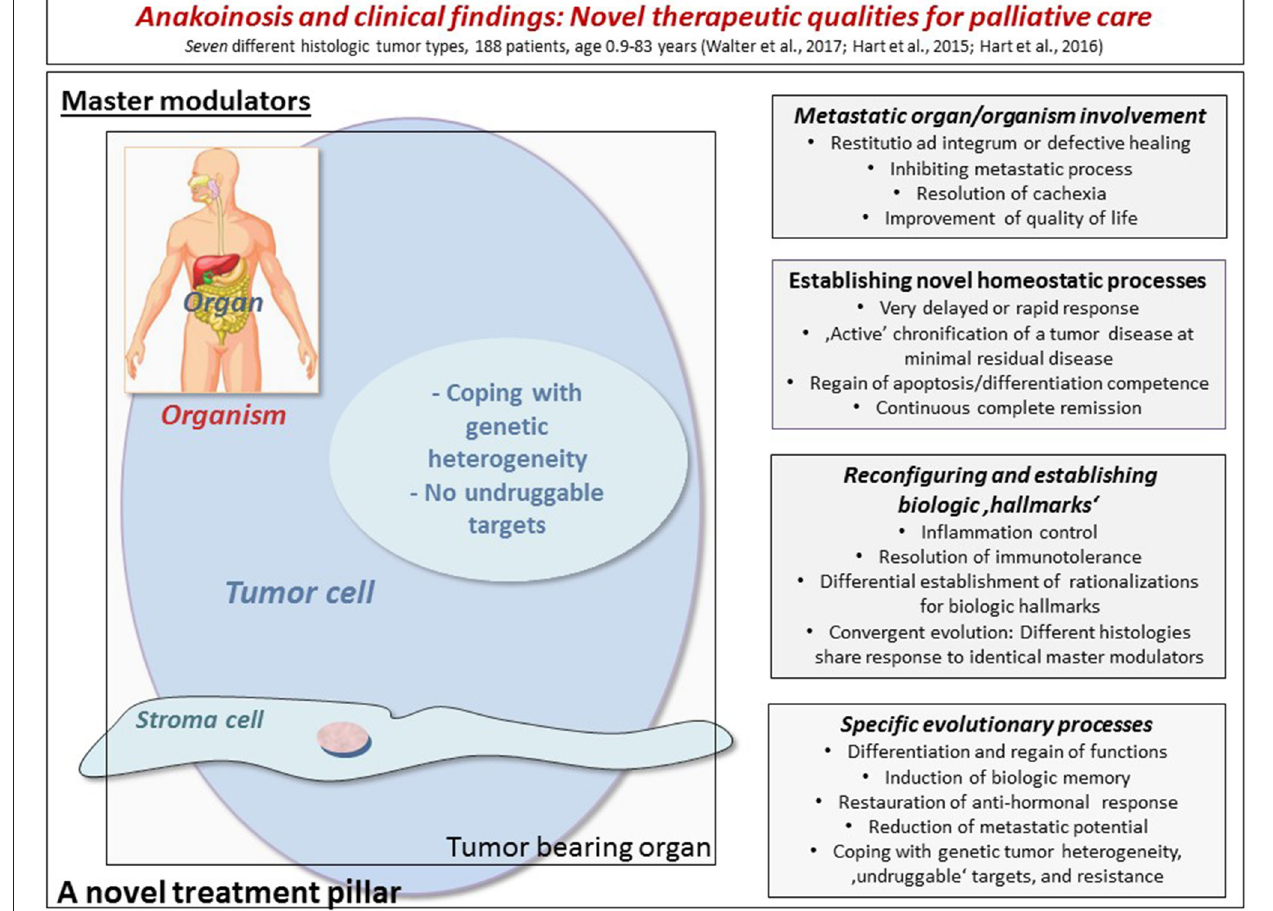
FIGURE 1 | The figure indicates diversified outcomes in a summary of selected published studies on seven different histologic tumor entities (altogether 188 refractory and metastatic patients with age, ranging from 0.9 to 83 years). By modulating therapeutically accessible communication tools (left side), homeostasis mechanisms may be “normalized” in the tumor tissue, in the tumor-bearing organ and organism as indicated by a broad diversification of palliative tumor care or even continuous complete remission. The right side lists the multifaceted clinically observed phenomena during anakoinosis inducing therapies. The diversified clinical outcomes highlight clinical advantages compared to classic targeted